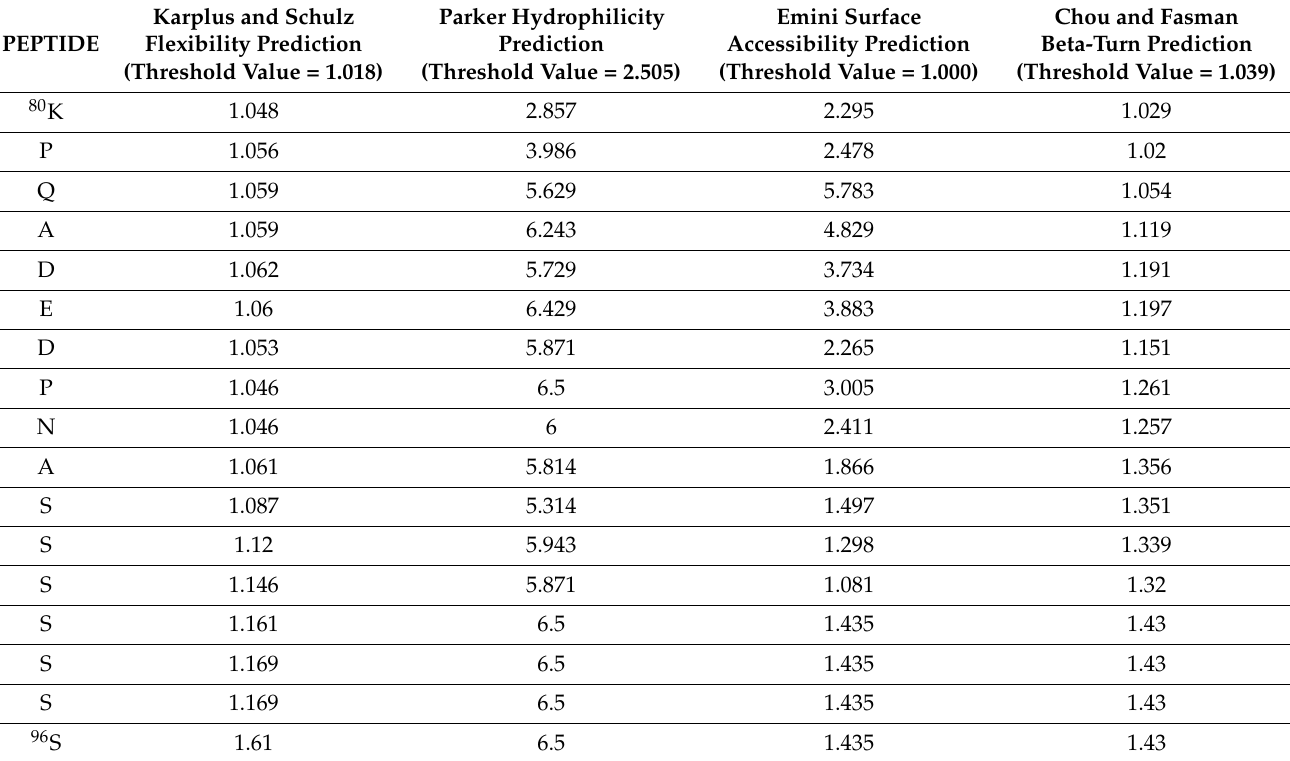
Table 4. Different prediction scores for each amino acid in the first predicted B cell epitope.